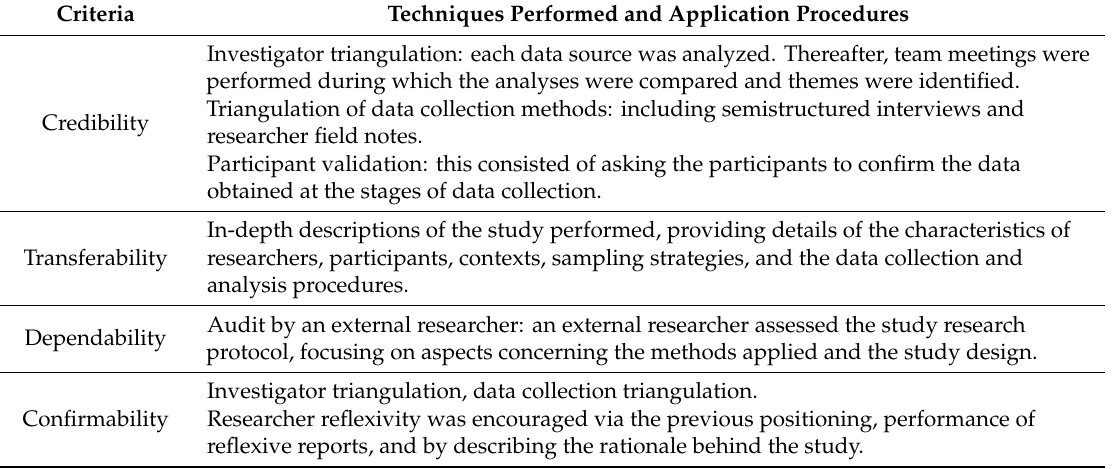
Table 3. Trustworthiness criteria